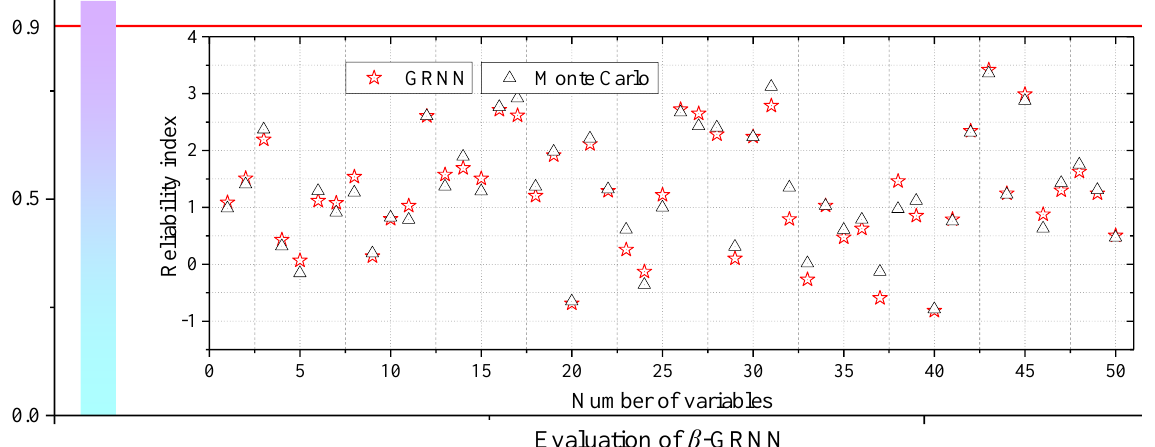
Figure 12. Reliability index from Monte Carlo and GRNN.